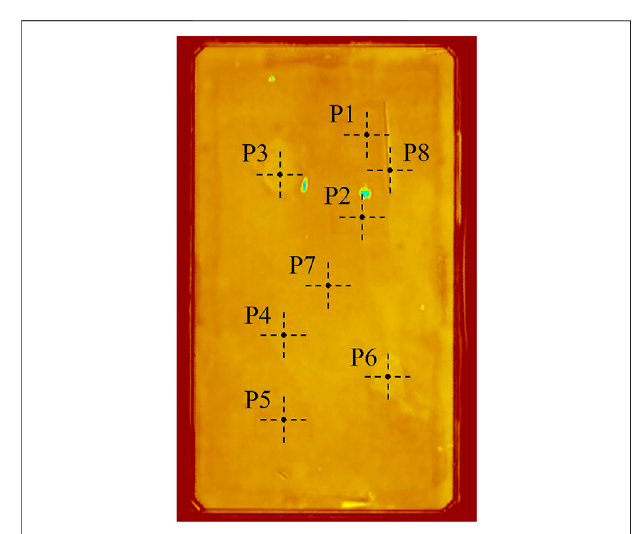
FIGURE 9 | Location of each defect selection point for signal